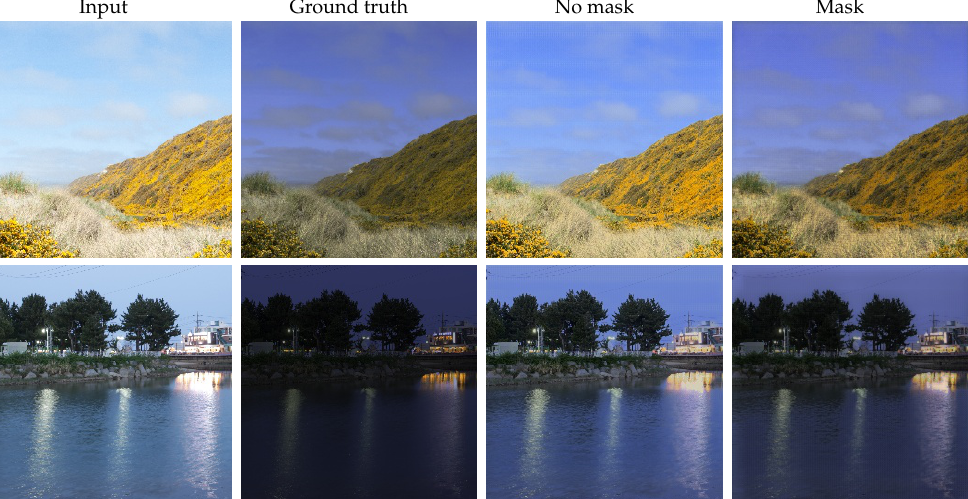
Figure 6. Result images with and without